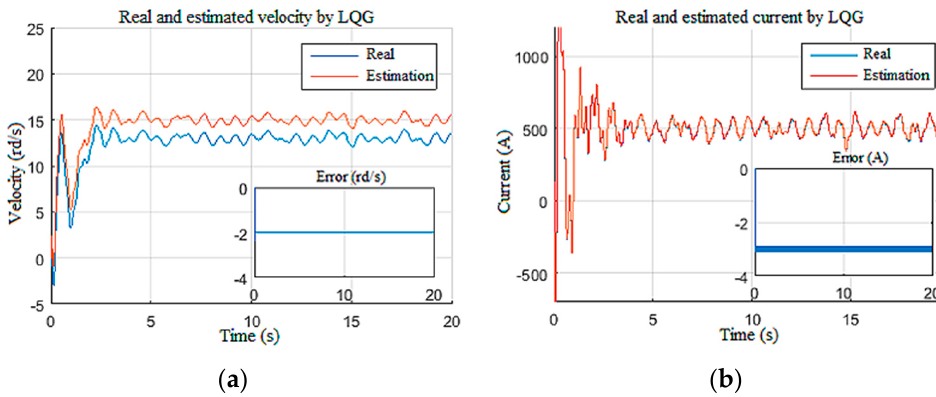
Figure 29. Performance limitation of LQG top drive responses: ( a ) velocity; ( b ) current.